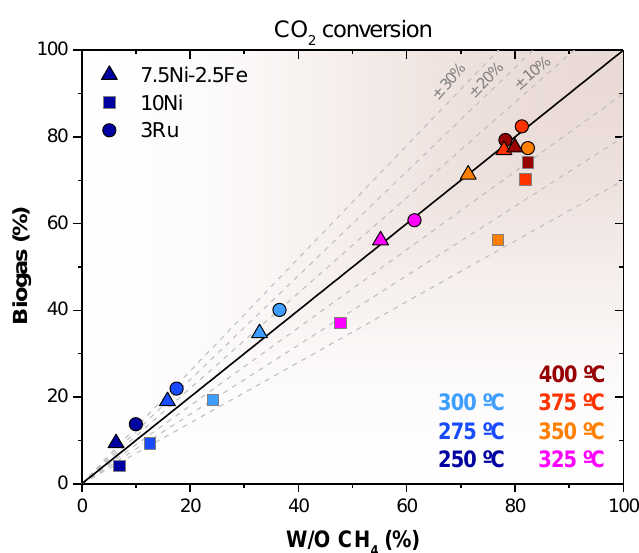
Figure 6. Influence on CO 2 conversion of co- feeding methane (‘Biogas’ vs. ‘W/O CH 4 ′ ) for all cata- lysts and different temperatures. Operating conditions (Table 2): q 0 = 250 STPmL·min −1 , H 2 :CO 2 = and different temperatures. Operating conditions (Table 2): q 0 = 250 STPmL · min − 1 , H 2 :CO 2 = 4:1, 4:1, CH 4 :CO 2 = 7:3, and WHSV = 30 × 10 3 (STPmL·g cat −1 ·h −1 ). CH 4 :CO 2 = 7:3, and WHSV = 30 × 10 3 (STPmL · g cat − 1 · h − 1